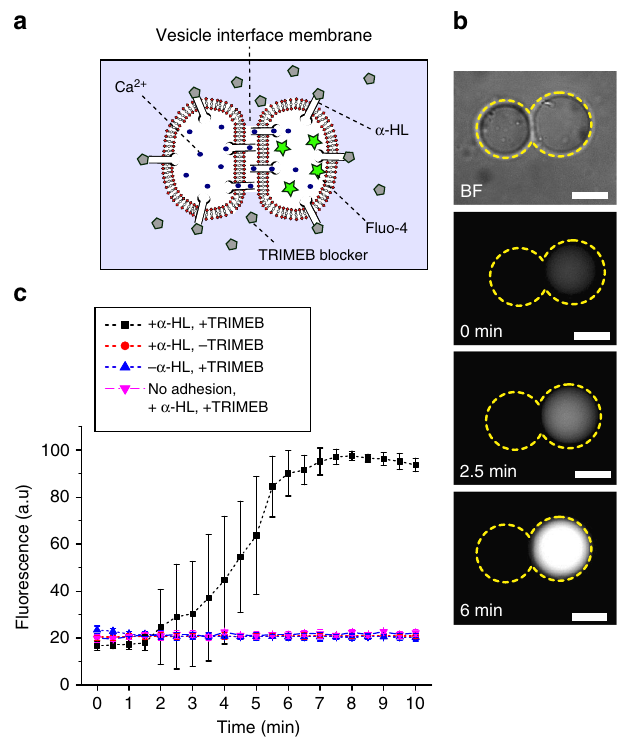
Fig. 6 Inter-vesicle communication. a Schematic of the engineered system enabling encapsulated content (Ca 2 + ) to translocate selectively through two sequential protein pores, into the adjacent compartment containing a Ca 2 + sensitive dye (Fluo-4). Leakage of ions through the external membranes is suppressed by the presence of channel blockers, which have a diminished ability to penetrate into the intermembrane space. b Bright fi eld and fl uorescence images of an adhered vesicle pair showing successful communication, with the dye-containing vesicle increasing in fl uorescence over time. Dotted yellow lines represent the vesicle boundaries. c Graph of fl uorescence intensity in the dye-containing compartment over time. Error bars represent standard deviation ( n =